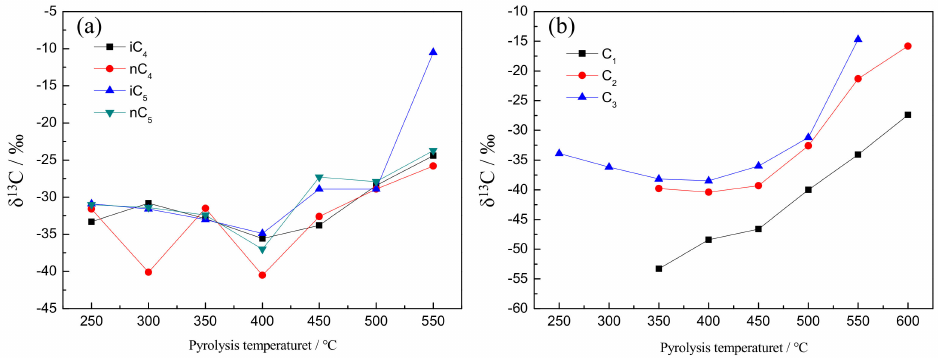
Figure 10. The carbon isotope composition of pyrolysis gas at different temperatures. ( a ) The carbon isotope composition of C 4-5 at different temperatures. ( b ) The carbon isotope composition of C 1-3 at different